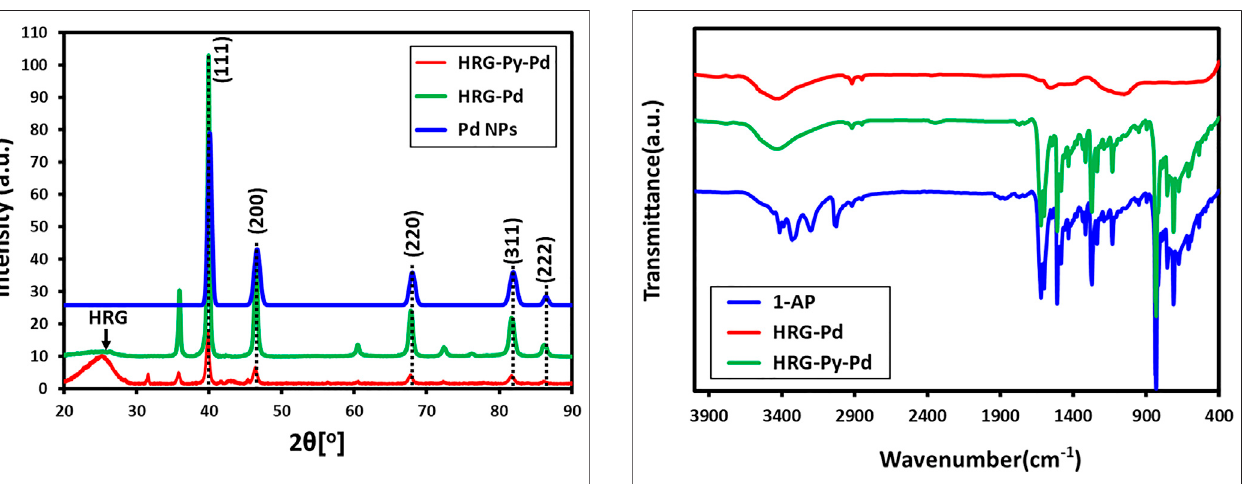
FIGURE 1 | XRD analysis of Pd NPs, HRG-Pd, and HRG-Py-Pd.